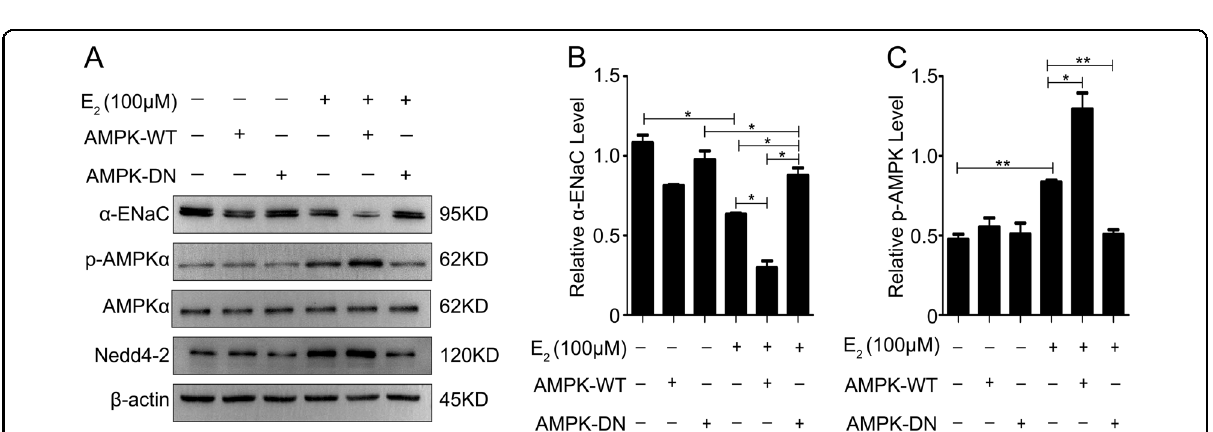
Fig. 9 Estrogen drives activation of AMPK-dependent inhibition of ENaC in mpkCCDc14 cells. a The expression levels of α -ENaC, phosphorylated AMPK, total AMPK and NEDD4-2 in mpkCCDc14 cells under different conditions were determined by western blot analysis. b Quanti fi cation of the α -ENaC expression shown in A normalized to β -actin expression. c Quanti fi cation of the phosphorylated AMPK expression shown in A normalized to β -actin expression. The bars are the means ± SE values from three independent experiments. * P < 0.05 and **P <